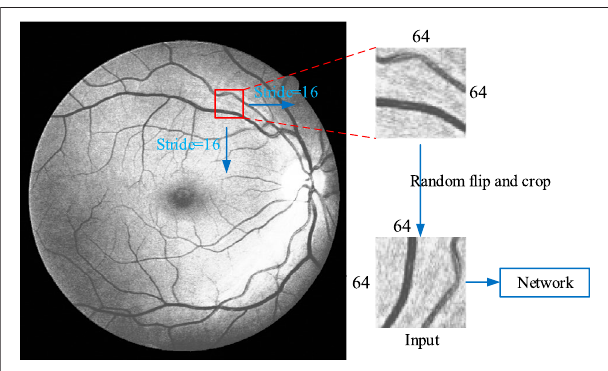
FIGURE 11 | Schematic diagram of windowing and data